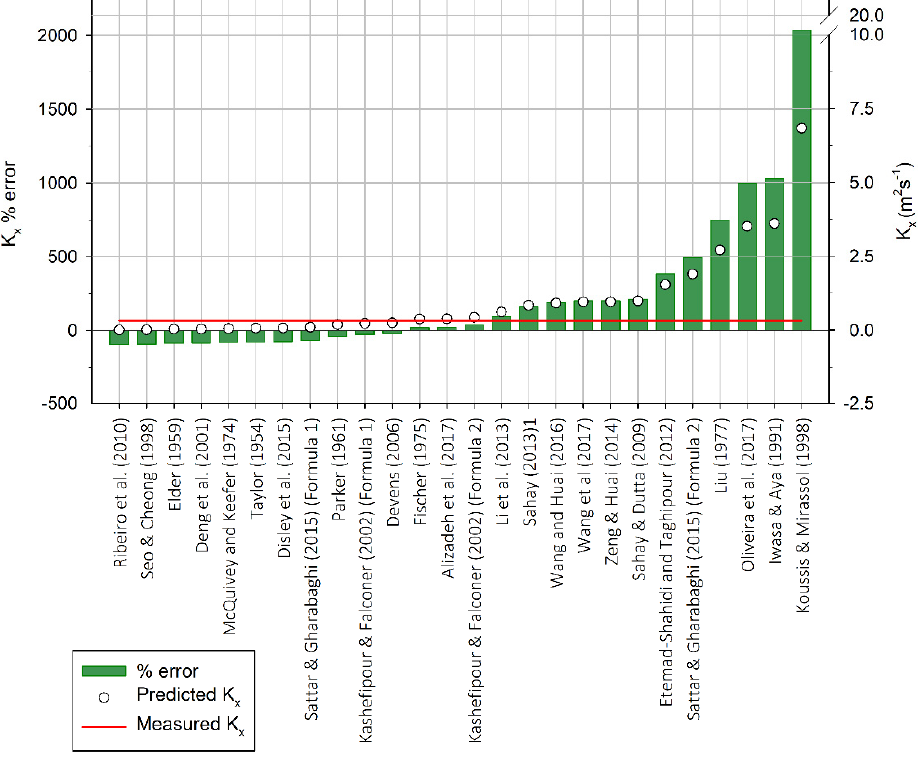
Figure 9. Percent error of the longitudinal dispersion coefficient value obtained with the predictive formulas when compared with the best-fit average value from the Hayami solution for the natural channel (red line).